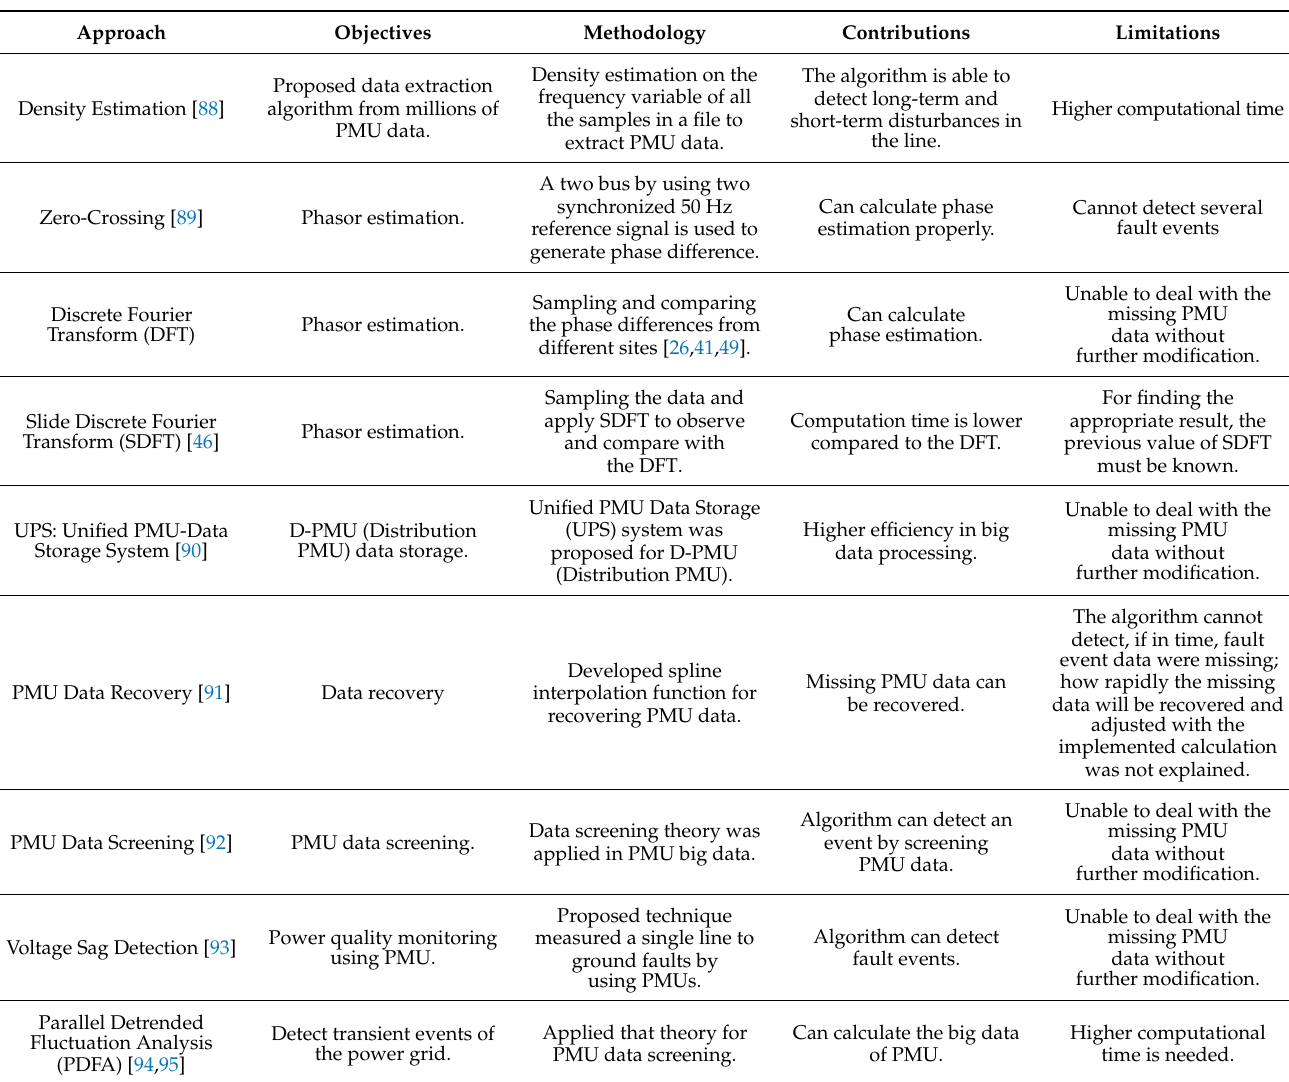
Table 3. Summary of PMU data analytic